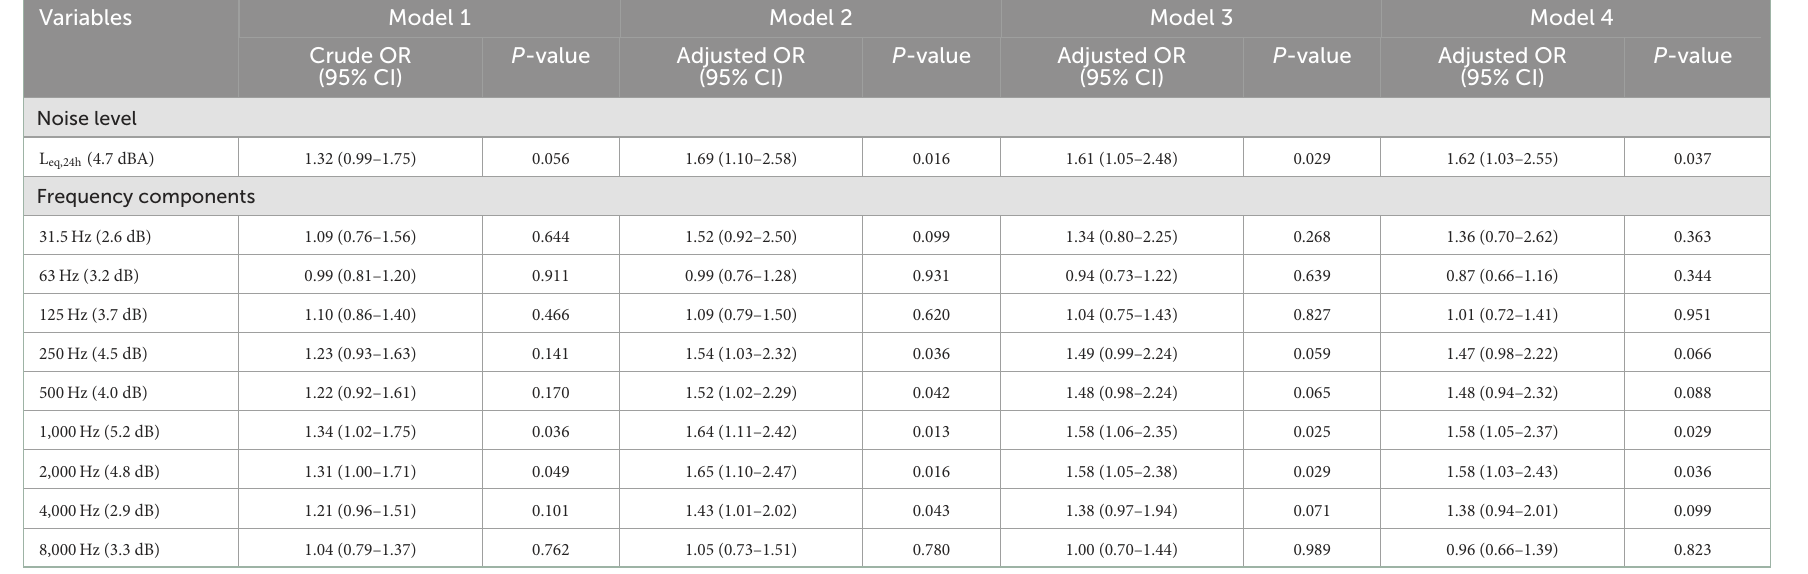
TABLE 4 Associations between one interquartile-range increase in annual 24-h road traffic noise and prevalent